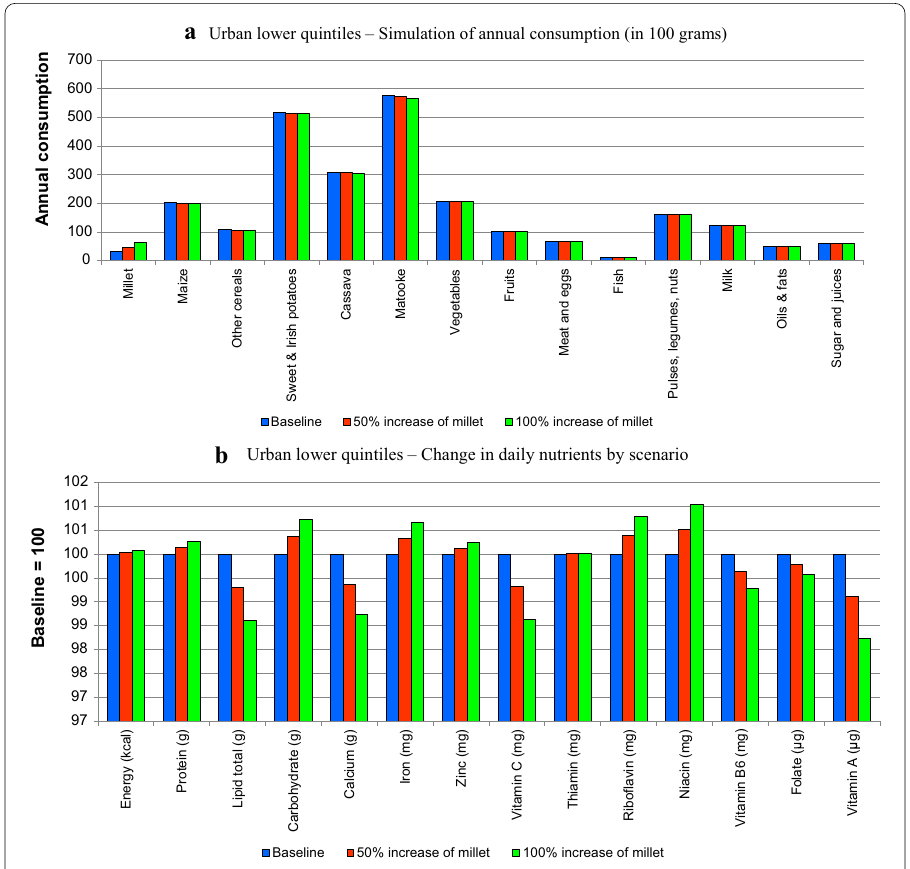
Fig. 4 a Urban lower quintiles—simulation of annual consumption (in 100 g). b Urban lower quintiles— change in daily nutrients by